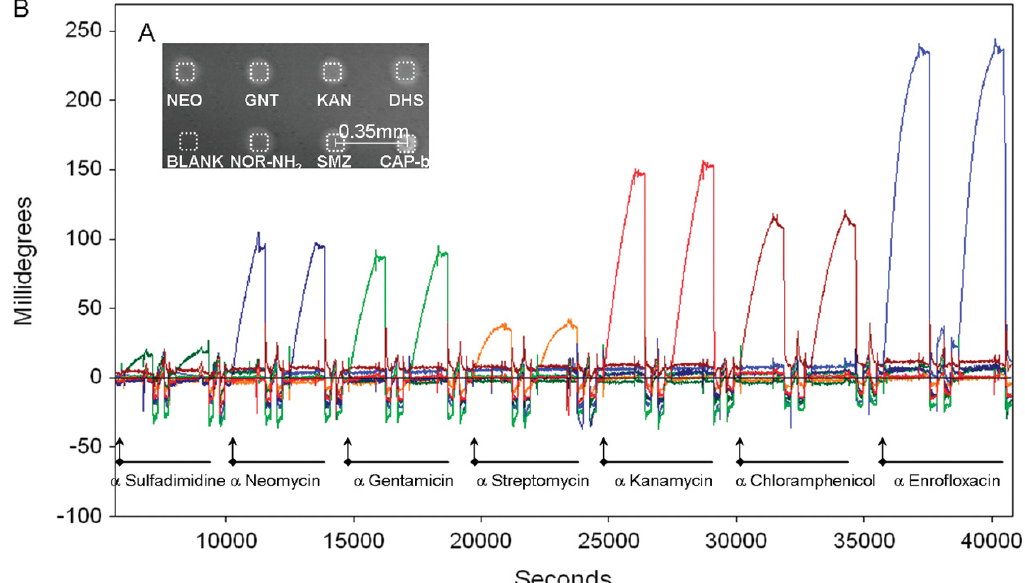
Figure 4. ( A ) SPR image of antibody binding onto different immobilized antibiotics (neomycin/NEO, gentamicin/GNT, kanamycin/KAN, dihydrostreptomycin/DHS, norfloxacin-NH derivative/NOR-NH , chloramphenicol/CAP, and 2 2